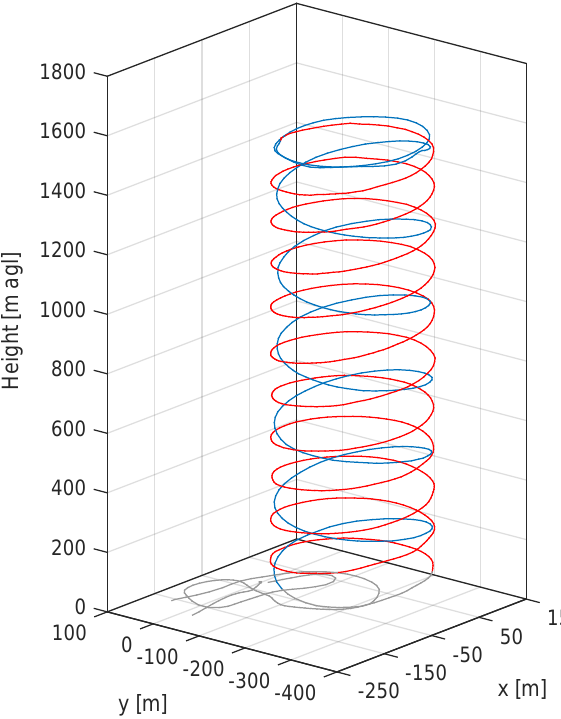
Figure 3. Typical atmospheric profiling flight pattern during the BLLAST campaign. The ascent is coloured in blue, the descent in red.